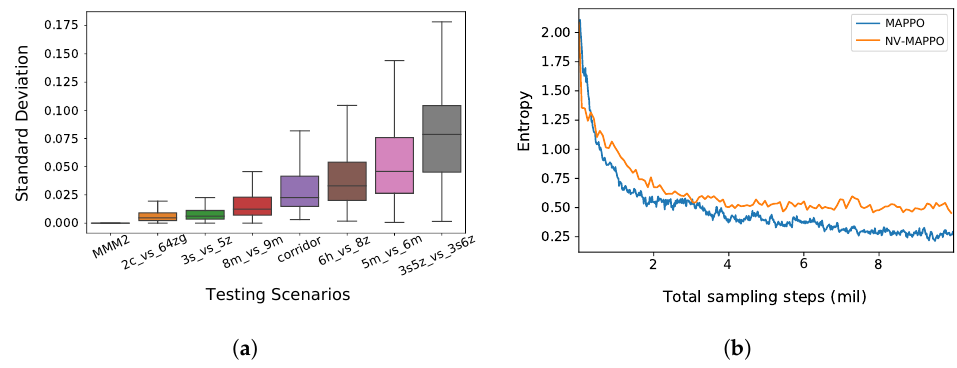
Figure 7. The increment of performance is positively correlated with the deviation of centralized value function, and injected noise can bring more exploration for agents. ( a ) Standard deviation of centralized value function on the agent dimension. ( b ) Average entropy of agents’ policies in 3s5z_vs_3s6z during